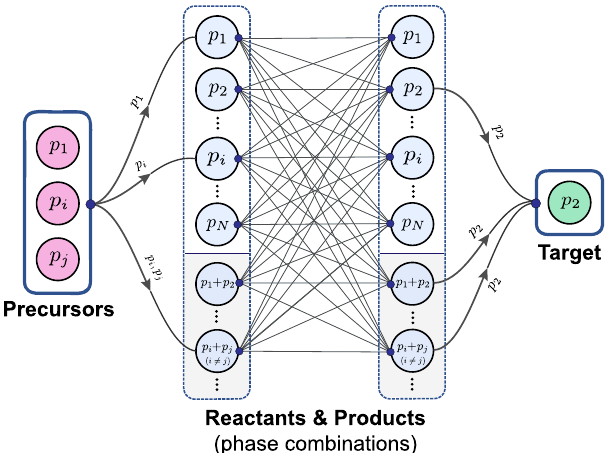
Fig. 4 Generalized graph architecture of a solid-state chemical reaction network. The reaction network is constructed for a hypothetical chemical system containing N phases p i ( i = 1, 2, … N ), with nodes made of distinct phase combinations up to maximum size, n . The precursors and target nodes link into and out of the densely connected network of reactions, respectively. The edge directions between the reactant and product nodes have been omitted for clarity; an alternate depiction of the network with edge directions is shown in Supplementary Fig. 1. These central edges include chemical reactions weighted by their cost value, as well as zero- weight edges which create loops from product nodes back to reactant nodes so that multiple-step reaction pathways can be